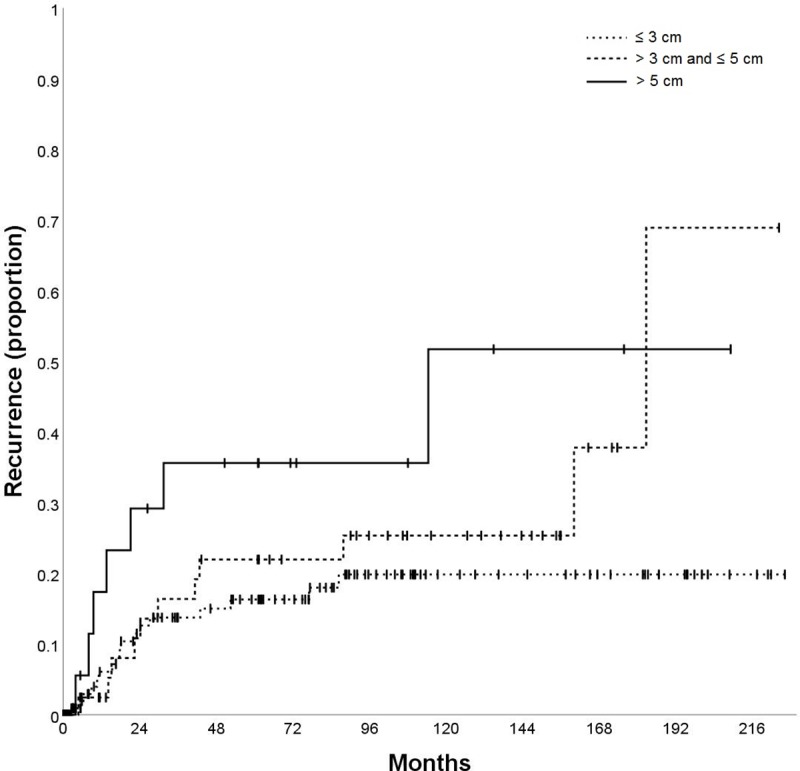
Time to recurrence (TTR) according to tumor size.